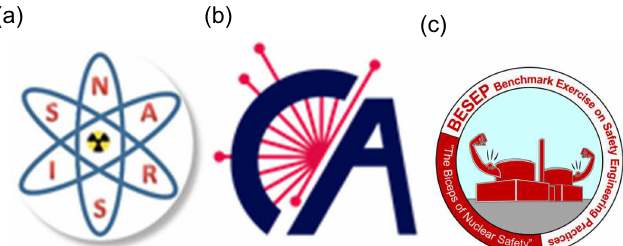
Fig. 1. The logo of (a) NARSIS; (b) R2CA; and (c) BESEP